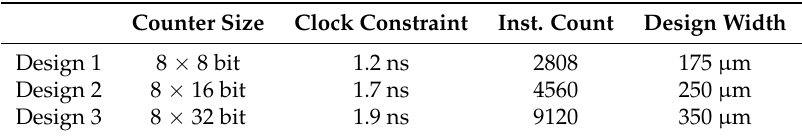
Table 1. Benchmarked